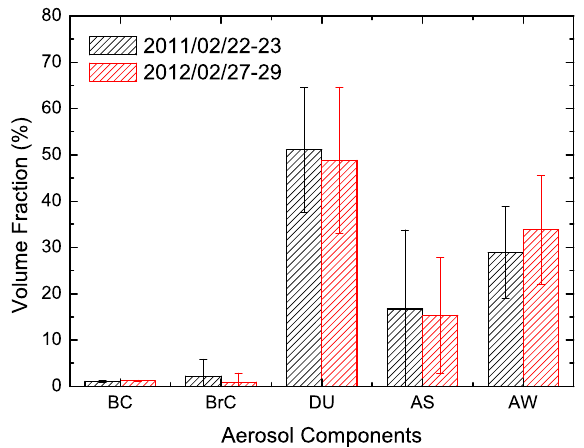
Fig. 11. The average volume fraction of chemical components dur- ing the haze events in 2011 and